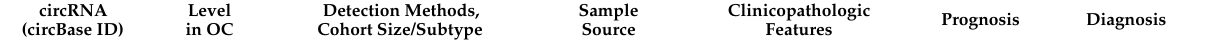
EOC vs. benign: AUC = 0.82 EOC vs. normal: AUC = 0.90 Early-stage EOC vs. benign: AUC = 0.81 Early stage EOC vs. normal: AUC =